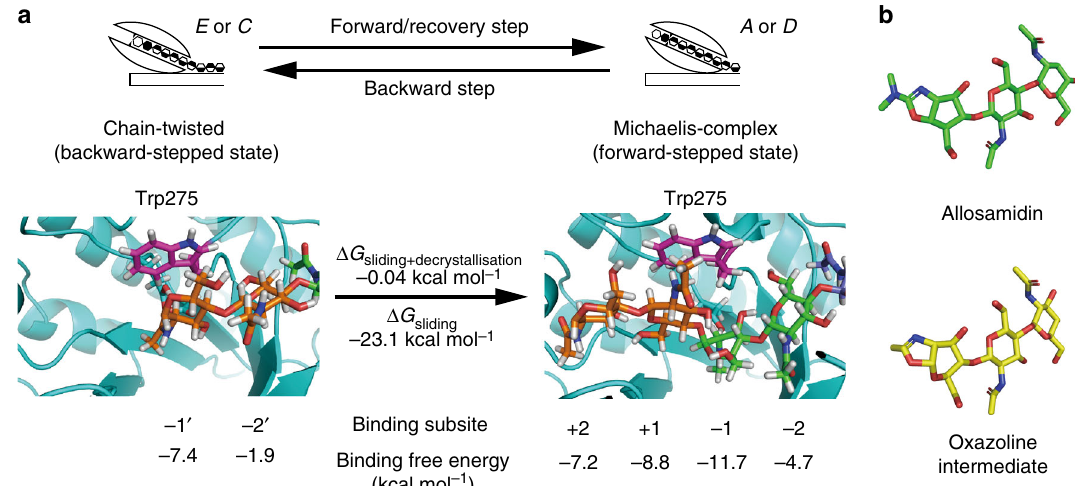
Fig. 5 Binding free energy and structural similarity of intermediate to inhibitor. a Binding free energies at each subsite of the Chain-twisted (left, backward- stepped state) and the Michaelis complex (right, forward-stepped state). Corresponding chitobiose units in each state are shown in the same colours. b Crystal structure of allosamidin bound to SmChiA (top, PDB ID; 1FFQ) and expected structure of oxazoline intermediate (bottom). Green or yellow: carbon; red: oxygen; blue: nitrogen